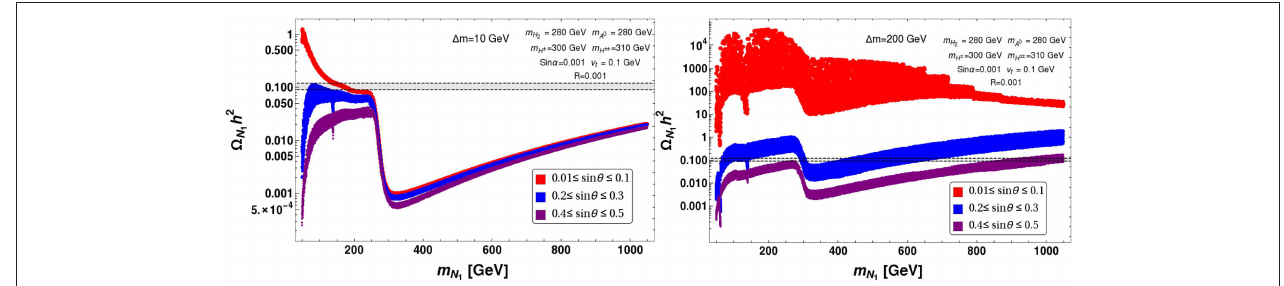
keeping fixed region of 1 m : 1 m 1